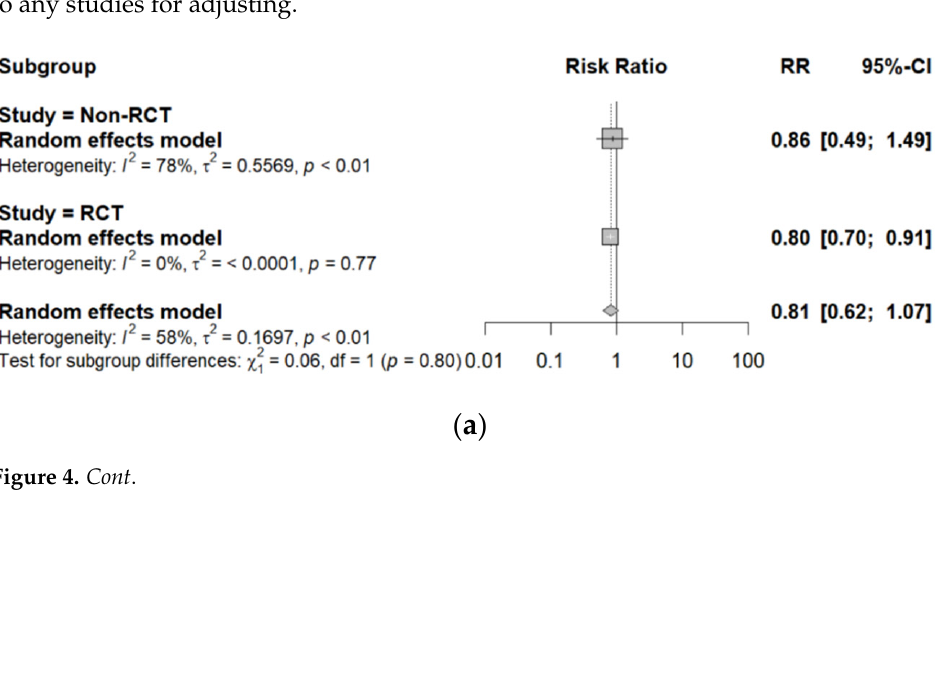
Figure 3. Results of the meta-analysis on the difference in the risk ratio (RR) for ( a ) all-cause mortal- ity, ( b ) ventilation incidence, ( c ) mean difference for hospitalization duration, and ( d ) length of ICU stay between intervention and control groups.